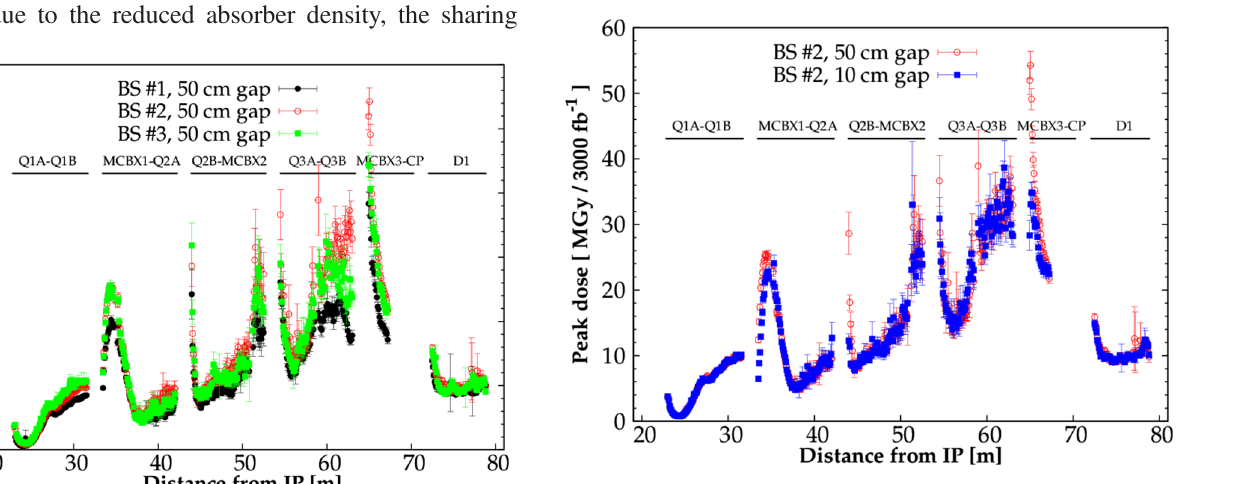
FIG. 13. Longitudinal distributions of peak dose on the inner coils of the IT magnets referring to different beam screen designs.